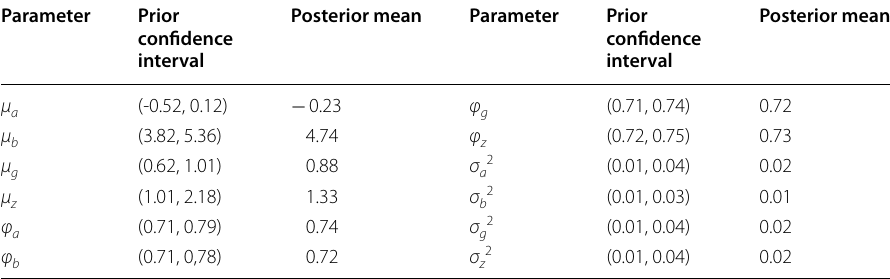
Table 2 Bayesian estimation results of volatility parameters